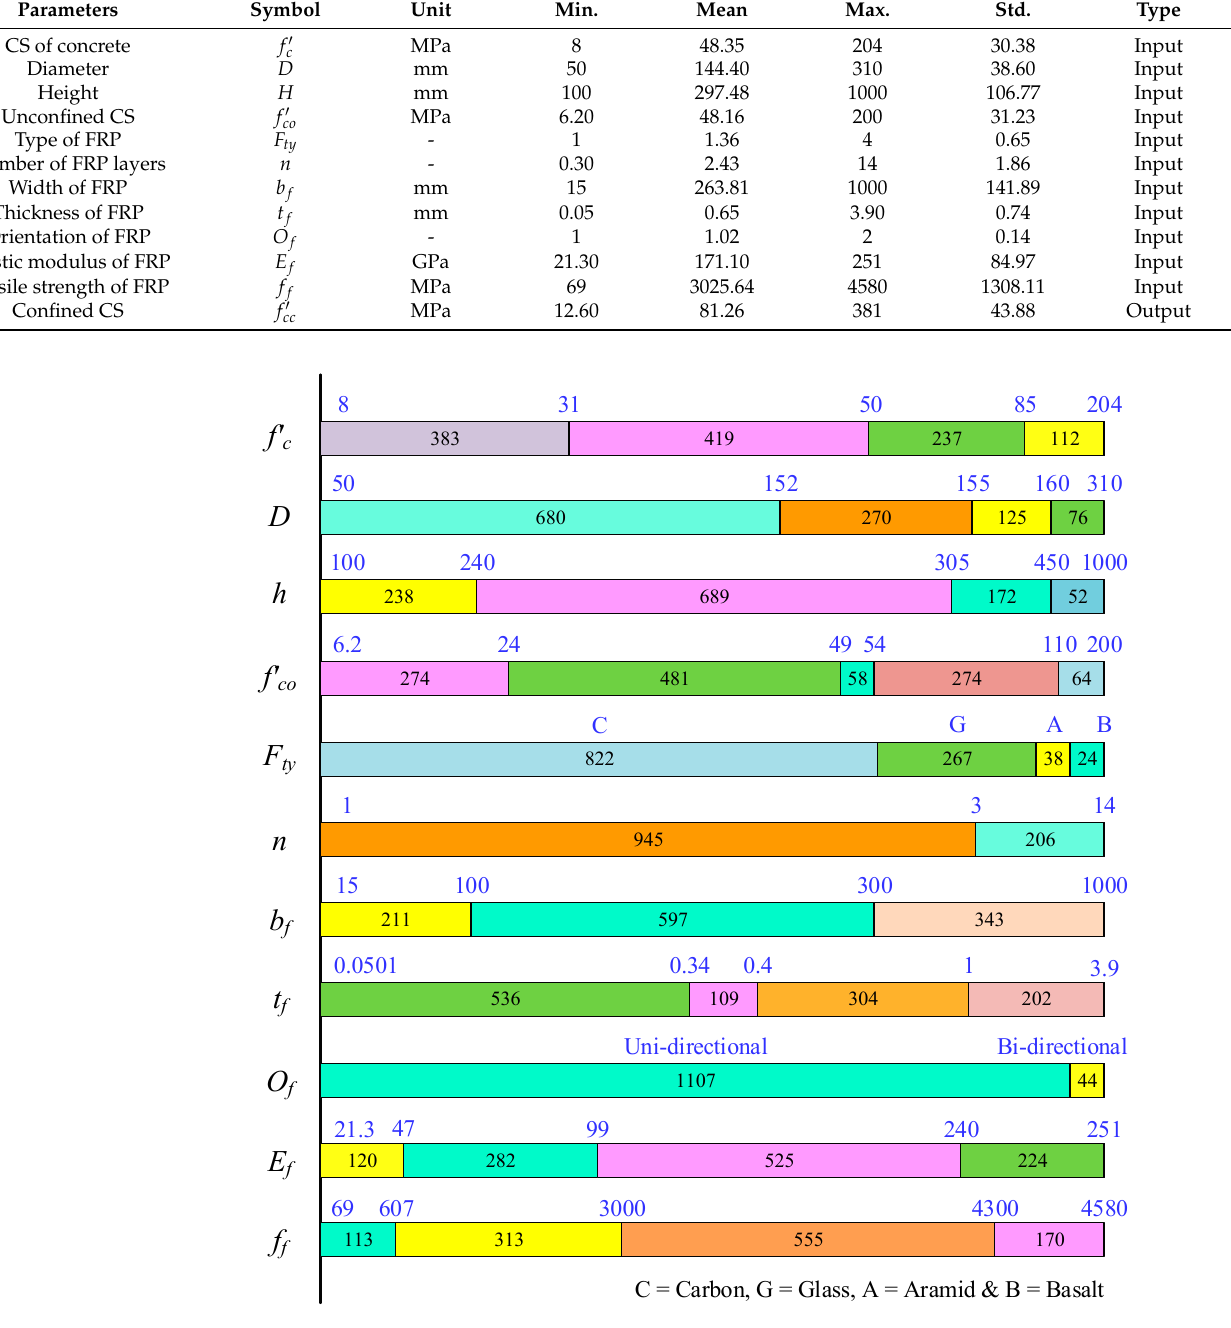
Table 2. Statistical indicators related to variables.